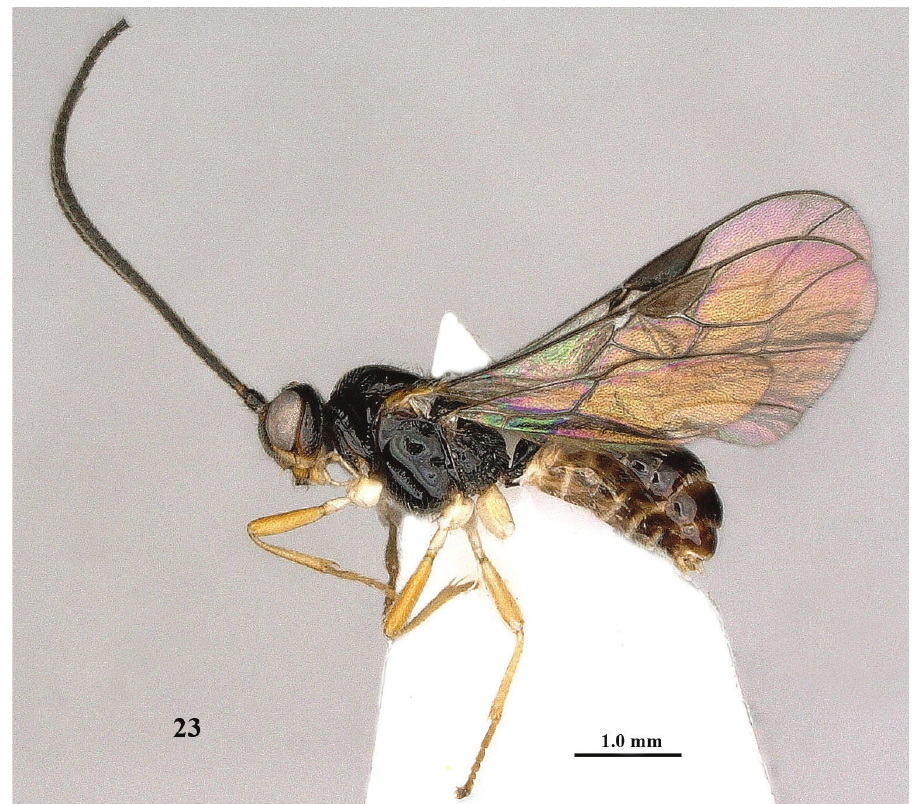
Figures 23. Rhogadopsis longivena sp. n., female,